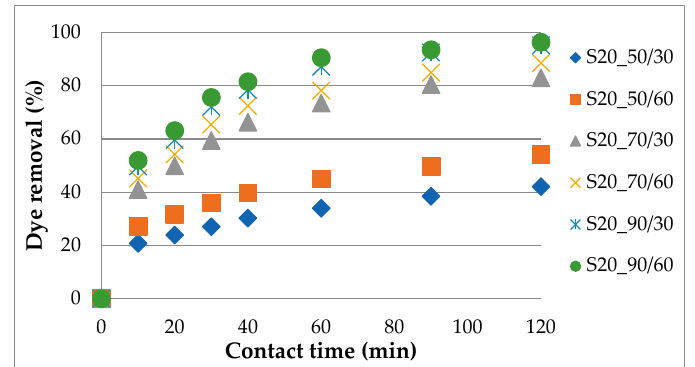
Figure 7. Dye removal vs contact time of rice husk treated with 20 g/L NaOH at 50, 70 and 90 °C for 30 and 60 min (adsorption conditions are 0.1 g/L Congo red, 25 °C, 10 g/L rice husk). Table 4. Evaluated Fisher test (F-test) and p -values for temperature of scouring and treatment time for percent of removed Congo red for 120 mins.